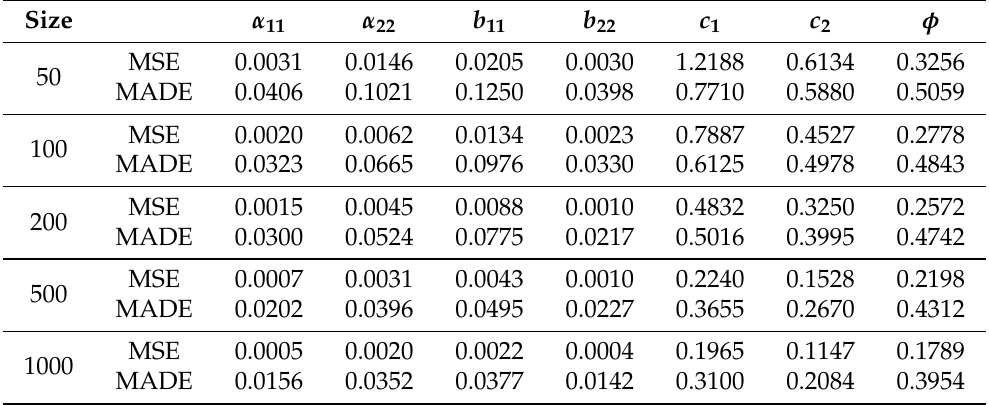
Table 5. Results for diagonal EBINAR(1) model with parameter